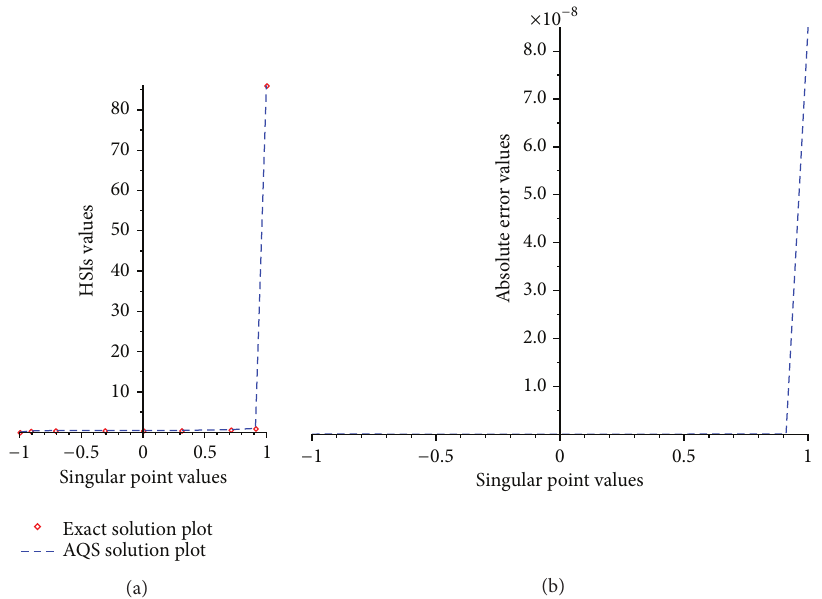
Figure 7: (a) Exact and AQS solutions when 𝑁 = 20 and ℎ(𝑡) = 1/(2 + 𝑡) and (b) absolute error between exact and AQS solution when 𝑁 = 20 and ℎ(𝑡) = 1/(2 + 𝑡) .